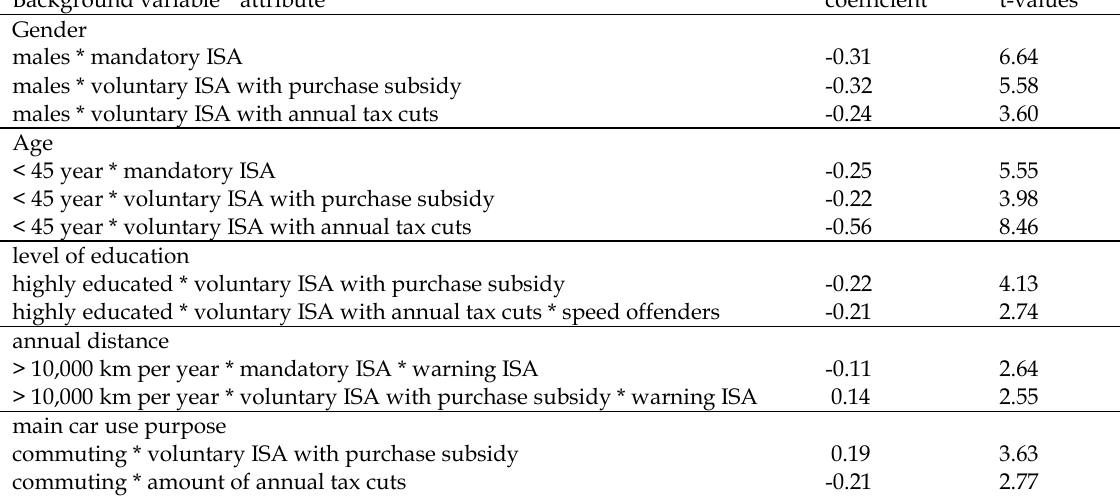
Table 3. Background Variable